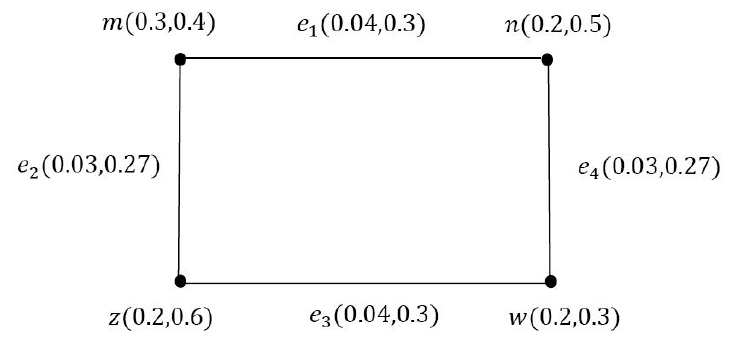
Figure 13. Restrained dominating sets in PVG ζ .